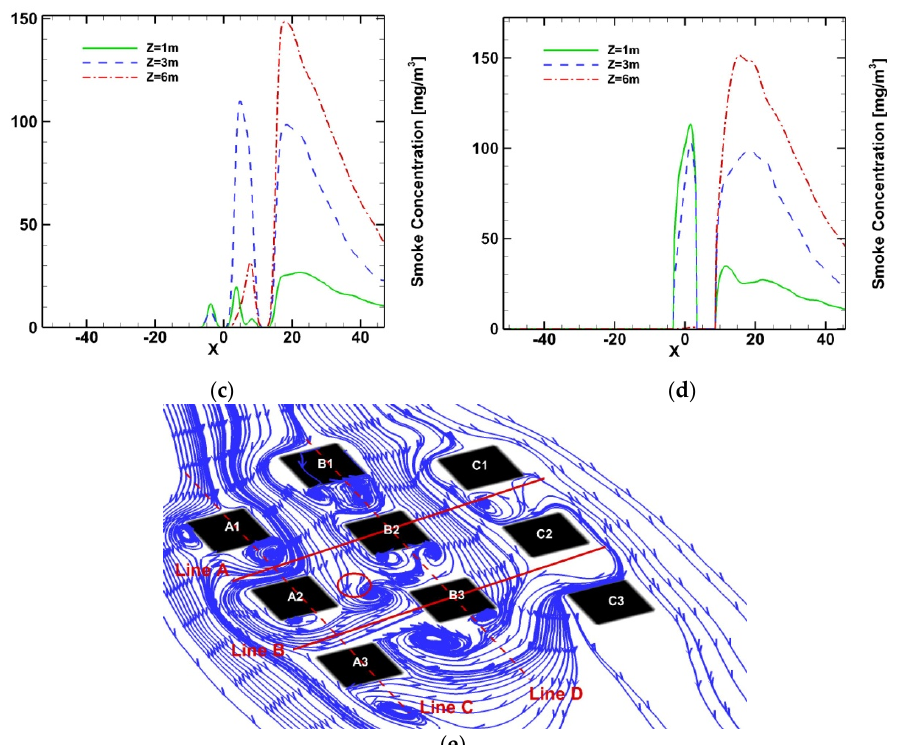
Figure 10. Smoke average concentration distribution along ( a ) line A; ( b ) line B; ( c ) line C; ( d ) D line for Case 2 and ( e ) the streamlines that define it.